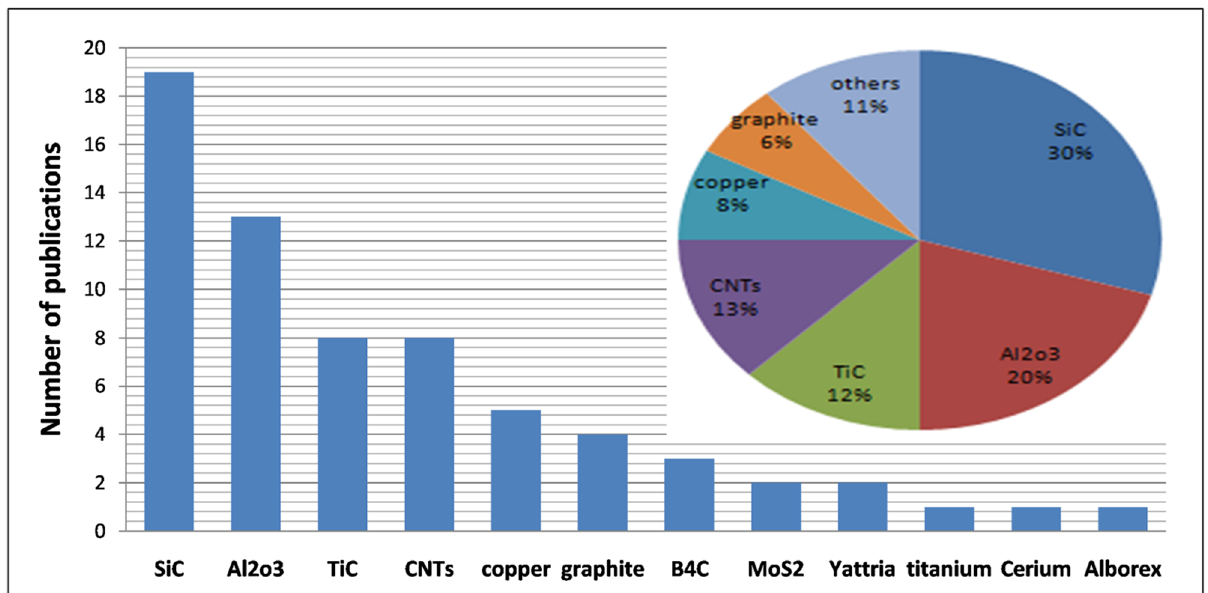
Figure 2: Percentage contribution of di ff erent reinforcements for fabrication of magnesium - based MMHC ’ s reviewed in this